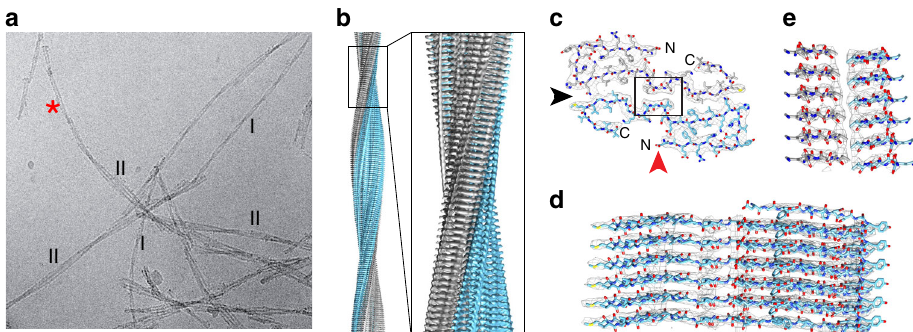
Fig. 2 Cryo-EM structure of fi bril morphology I. a Representative cryo-EM micrograph indicating fi bril morphologies I and II. Asterisk: morphology I-like fi bril emanating from morphology II. Scale bar: 50 nm. b Side view of the reconstructed 3D map. c Cross-sectional view of one molecular layer of the fi bril superimposed with the molecular model. d Side view of the 3D map of a six-layer peptide stack superimposed with the molecular model. The stack is viewed along the red arrow head in panel ( c ). e Side view of six molecular layers of the boxed region from panel ( c ), viewed along the black arrow head. The fi gure illustrates the staggering of the two peptide stacks. The two peptide stacks are colored gray and blue in panels ( b – d )